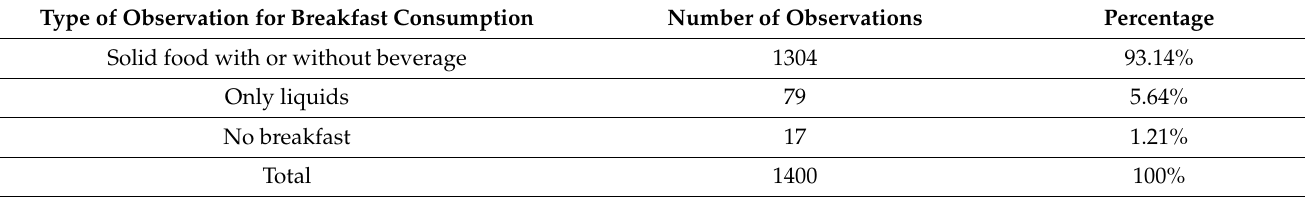
Table 1. Observations for breakfast consumption derived from 200 fully completed diaries. Type of Observation for Breakfast